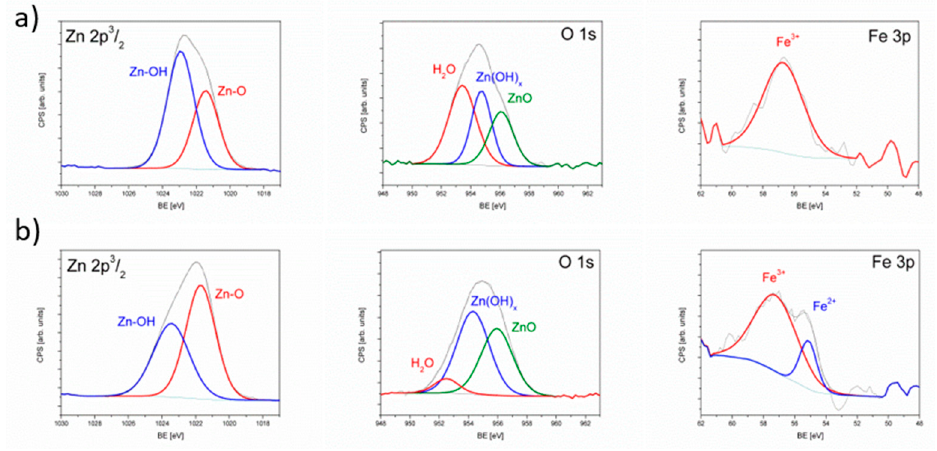
Figure 3. XPS analysis of Zn 2p, O 1s and Fe 3p lines in ZnO:Fe 3+ sample ( a ) and ZnO:Fe 3+,2+ sample ( b ). Table 1. Energy-dispersive X-ray spectroscopy (EDX) measured elemental composition of ZnO:Fe 3+ and ZnO:Fe 3+,2+ samples. Concentrations given in atomic %.